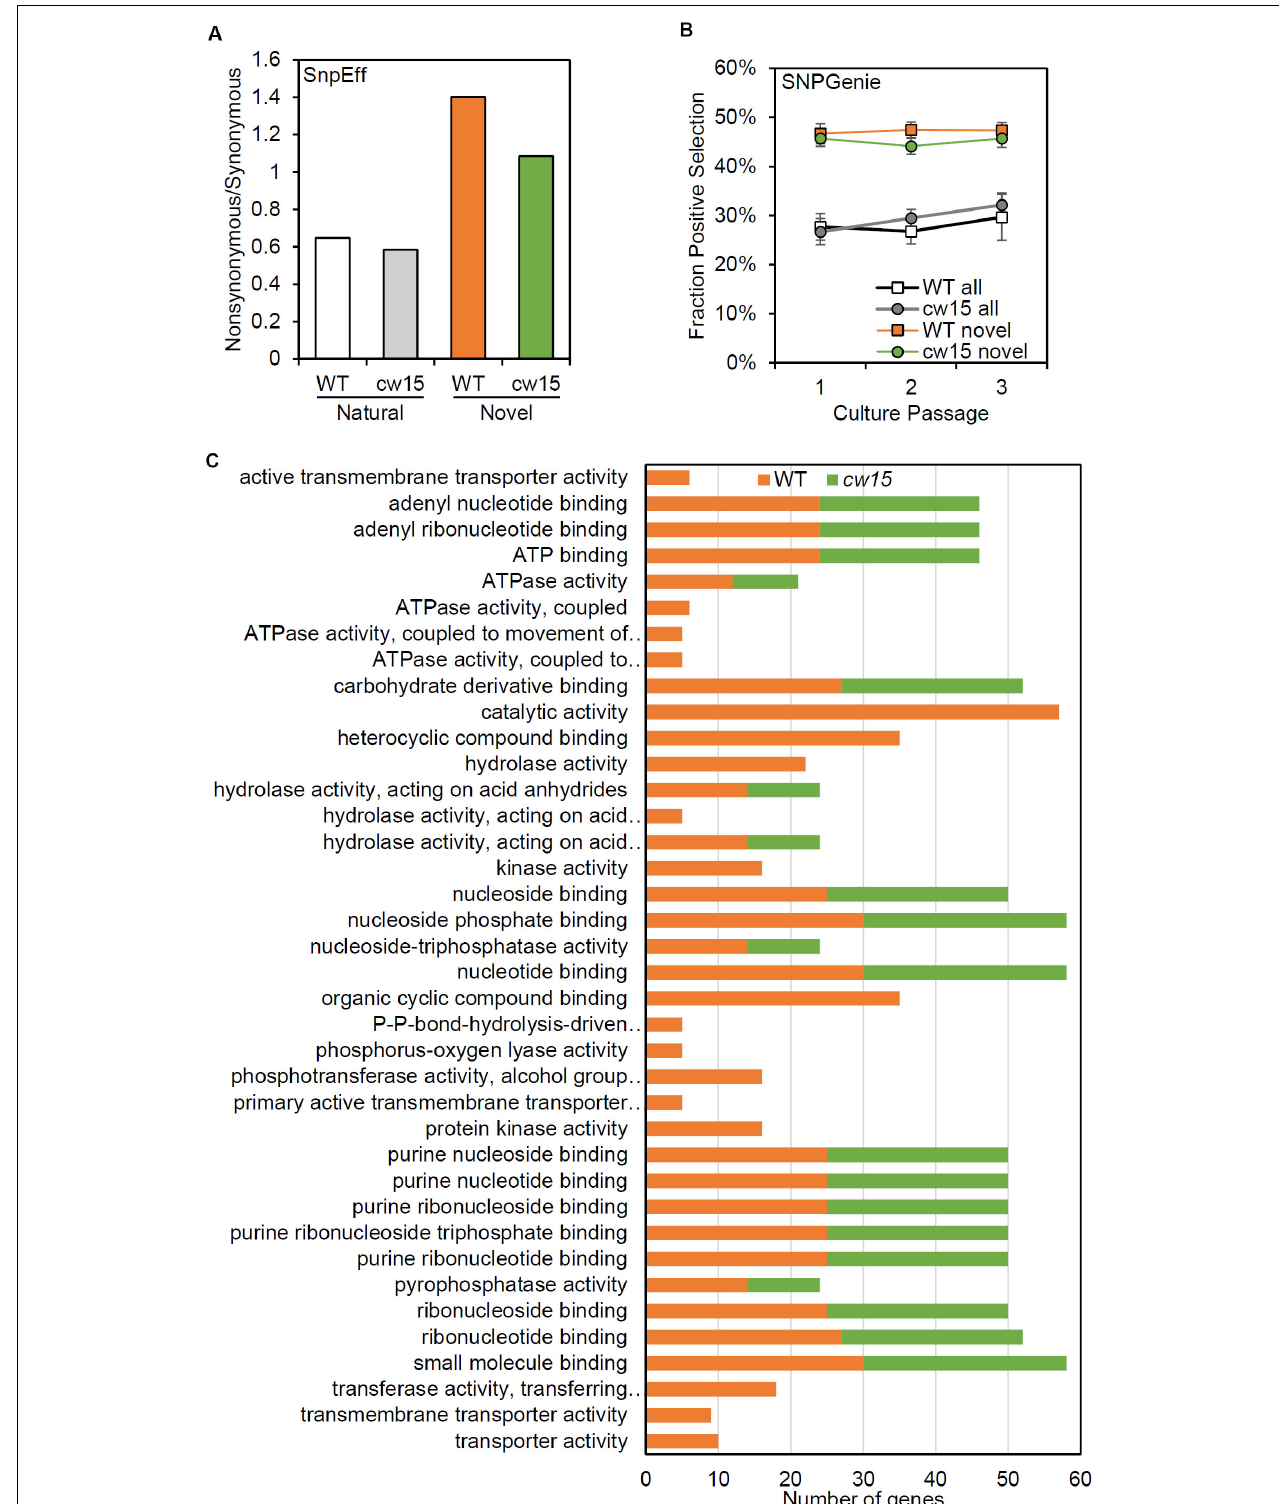
FIGURE 7 | Novel variants are enriched for predicted protein coding changes. (A) Ratio of non-synonymous to synonymous variants based on SnpEff annotations. White and gray show natural variants detected. Orange and green show novel variants. (B) Average fraction of genes showing positive selection of all genes tested with SNPGenie. Averages are from six libraries per passage. Error bars are standard deviations. (C) Enriched GO terms for genes with positive selection.